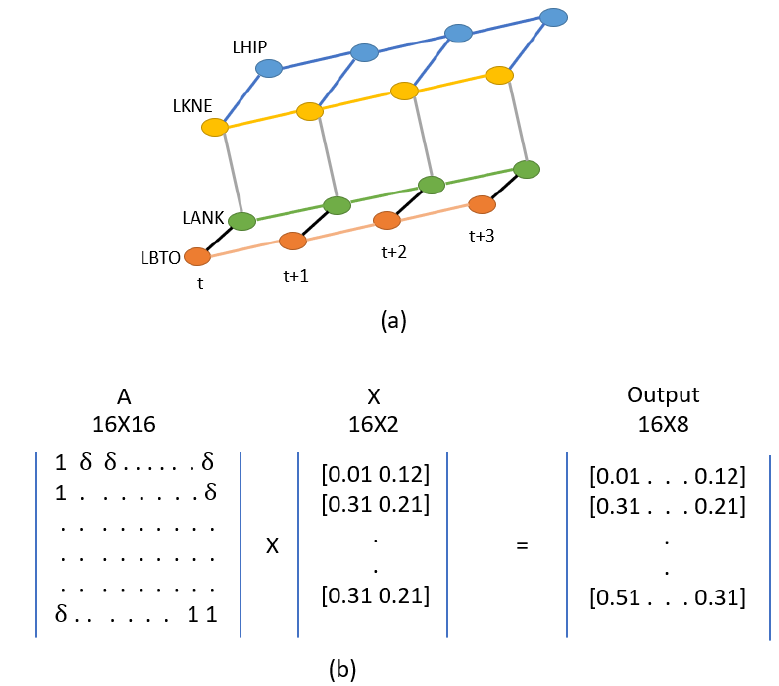
Figure 2. Illustration of ( a ) proposed method using an example of N = 16, where N is the total number of keypoints in 4 frames. Each point at t shows the joints of left skeleton. The left hip (LHIP) at t is connected to the left knee (LKNE) and LHIP at t + 1. ( b ) For the first graph convolutional layer the ( x , y ) position of each joints is taken as a feature. The adjacency matrix A describes the relation of each joints with each other. The LHIP joint in the frame t is connected with the LANK in the same frame t and with LHIP in frame t + 1. Hence, for LHIP in frame t , 1 is assigned for joints that have direct connection. Basically, The ouput feature is computed from matrix multiplication of the input feature X and The adjacency matrix A . To avoid the impact of zero value in matrix multiplication we set a very small value δ = 0.01 for the joints that are not